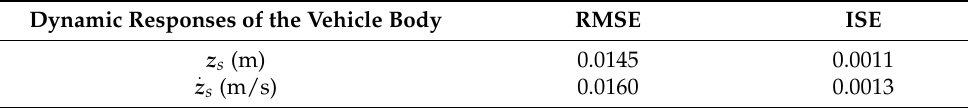
Figure 10. Dynamic responses of vehicle body: ( a ) vertical displacement; ( b ) vertical velocity. Table 3. Dynamic responses of the vehicle body compared with the software